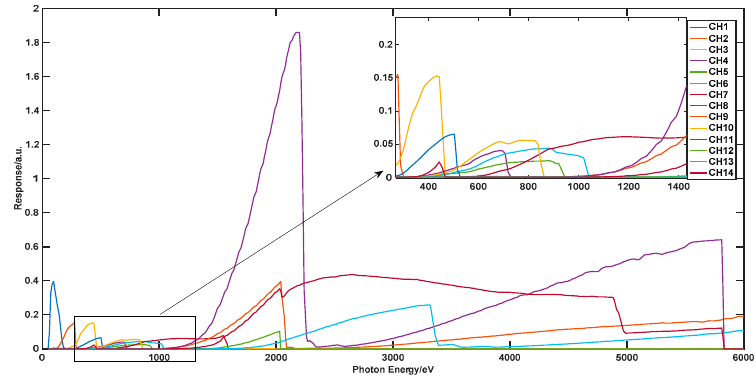
Figure 3. Fourteen channel responses of the soft X-ray spectrometer.